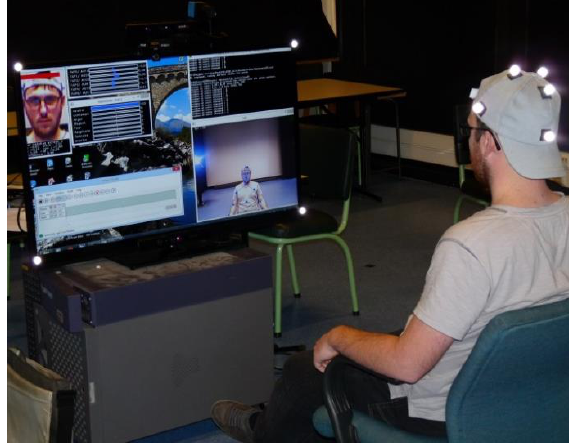
Figure 7. Infrared reflectors on viewer hat sitting in front of the TV.